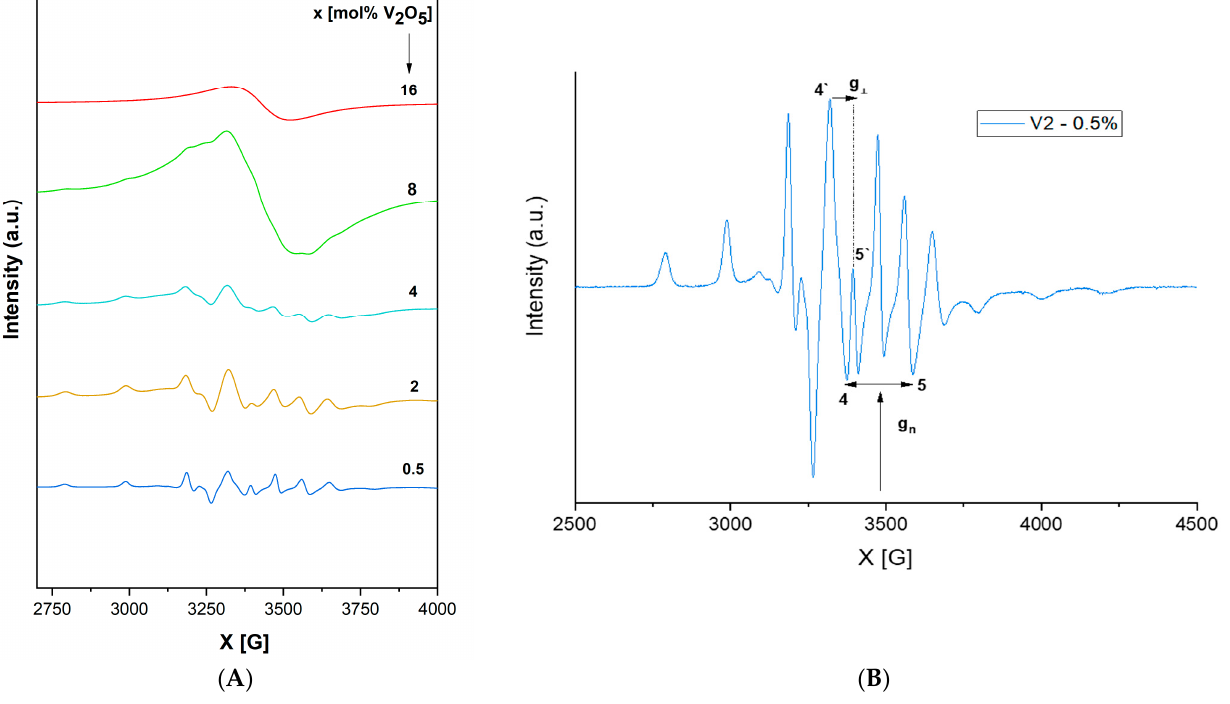
Figure 5. ( A ). EPR spectra of a xV 2 O 5 ∙ (100 − x) [CaF 2 ∙ 3P 2 O 5 ∙ CaO] glass system with 0 ≤ x ≤ 16 mol%. ( B ). Individual EPR spectra of a xV 2 O 5 ∙ (100 − x) [CaF 2 ∙ 3P 2 O 5 ∙ CaO] glass system with x = 0. 5